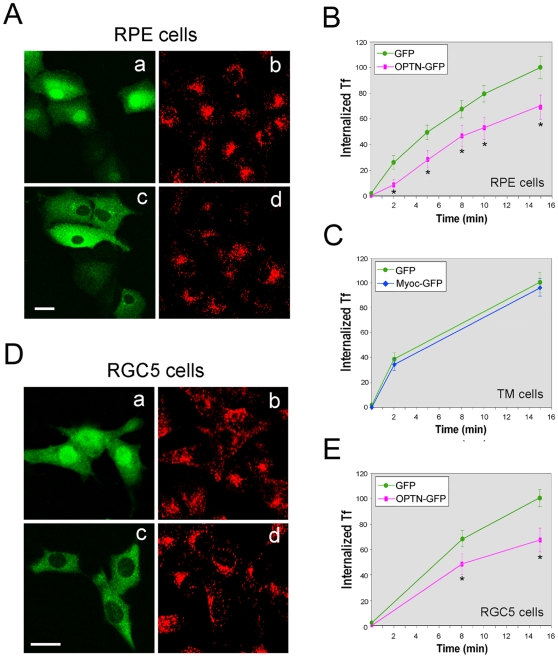
Overexpression of optineurin-GFP (OPTNWT-GFP) but not myocilin-GFP (MYOC-GFP) impedes transferrin (Tf) uptake.(A) Fluorescent images of GFP (Aa and Ab)- and OPTNWT-GFP (Ac and Ad)-expressing RPE cells after incubation with Texas red-Tf (TR-Tf) for 15 min. The cells were fixed and the fluorescent images were captured under a Leica confocal microscope. Transfected cells (green) are seen in Aa and Ac and the internalized TR-Tf (red) is seen in Ab and Ad. Scale bar, 20 µm. (B) Quantification of TR-Tf uptake in GFP (green filled circles)-, and OPTNWT-GFP (pink squares)-expressing RPE cells. Fluorescence intensity of TR-Tf in the cells was measured at 0-, 2-, 5-, 8-, 10-, and 15-min time points. Images in seven randomly selected 20× fields, each containing at least 8 transfected cells, were analyzed. TR-Tf internalization for samples at each time point is expressed as percentage relative to that of the 15-min uptake in GFP-expressing mock control cells. Data presented are mean ± standard deviation (SD) from a representative of three independent experiments. *, P<0.0001 (n = 8) compared to GFP controls. (C) Quantification of TR-Tf uptake in GFP (green filled circles)-, or MYOC-GFP (blue diamonds)-expressing TM cells. (D) Fluorescent images of GFP (Da and Db)- and OPTNWT-GFP (Dc and Dd)-expressing RGC5 cells (green) after incubation with TR-Tf (red, Db and Dd) for 15 min. Scale bar, 20 µm. (E) Quantification of TR-Tf uptake in GFP (green filled circles)-, and OPTNWT-GFP (pink squares)-expressing RGC5 cells. Fluorescence intensity of TR-Tf in the cells was measured at the 0-, 8-, and 15-min time points. The uptake is expressed as percentage (mean ± SD) relative to that of the 15-min uptake in GFP-expressing control cells. Experiments were repeated at least three times with similar results. *, P<0.001 compared to GFP controls.